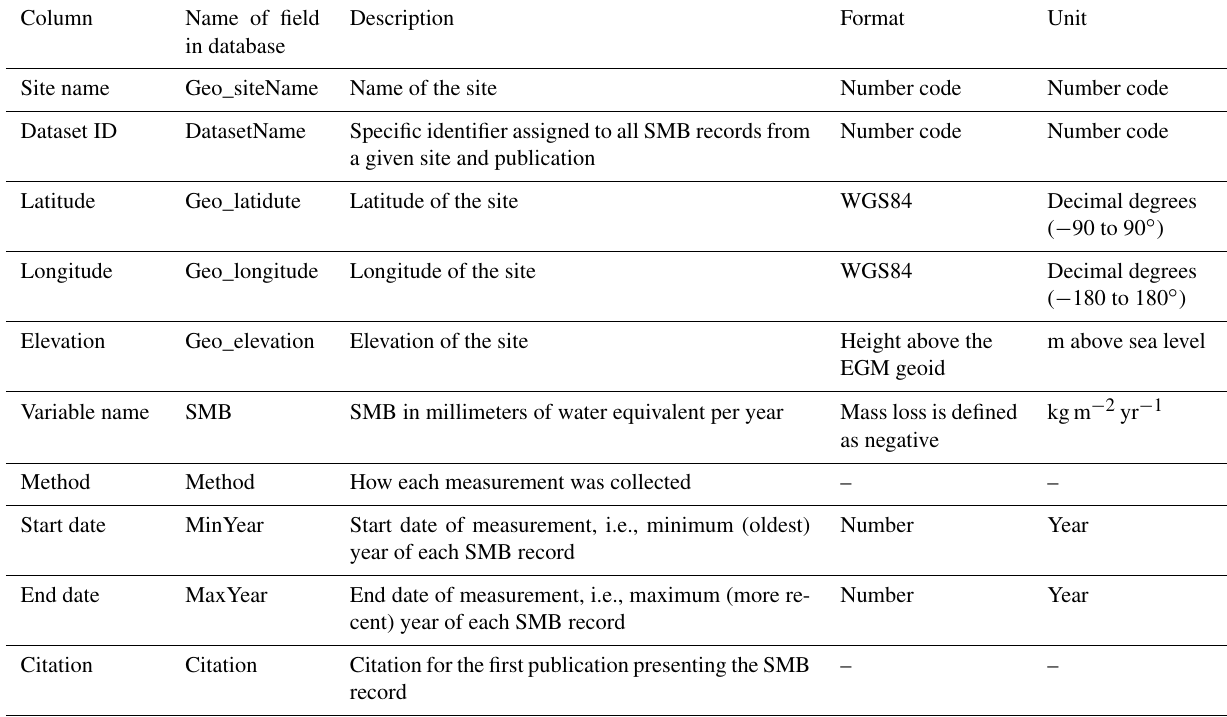
Table 1. Brief description of metadata fields used in the Antarctic SMB observation